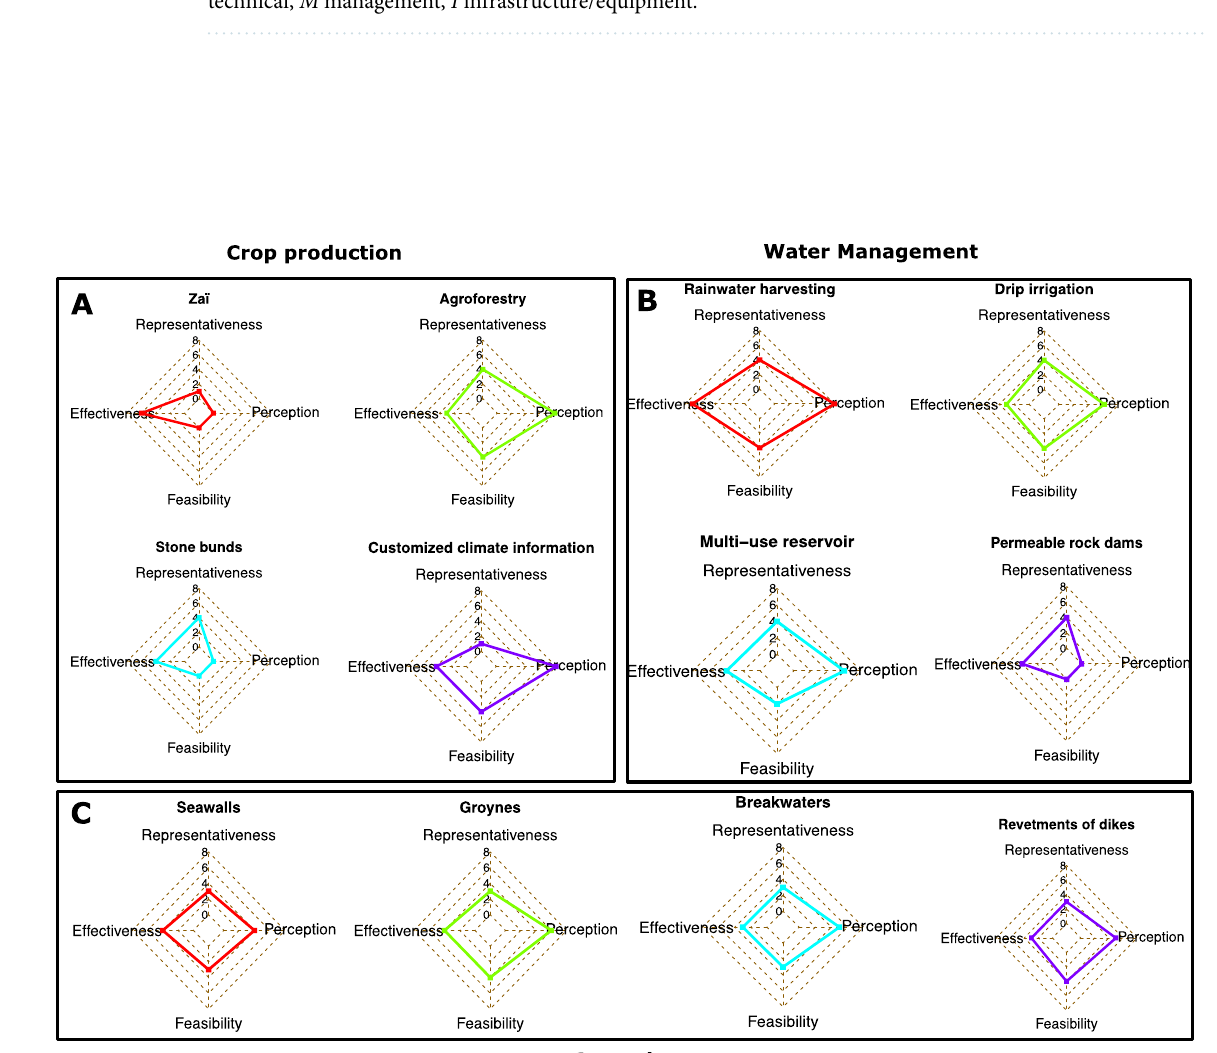
Table 2. List of adaptation practices for the coastal zones. *Scale: S small, M medium, L large. **Category: T technical, M management, I infrastructure/equipment.